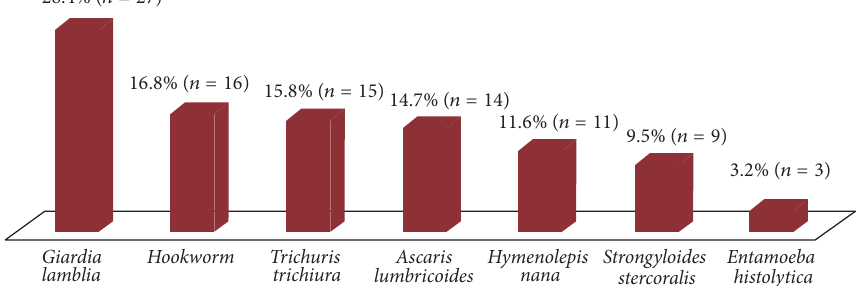
Figure 1: Proportion of different intestinal parasites among intestinal parasite infected pregnant women attending ANC clinic at Pugnido ARRA Health Center in Gambela, Western Ethiopia, April 15–June 30/2015 ( 𝑛 = 95 ).